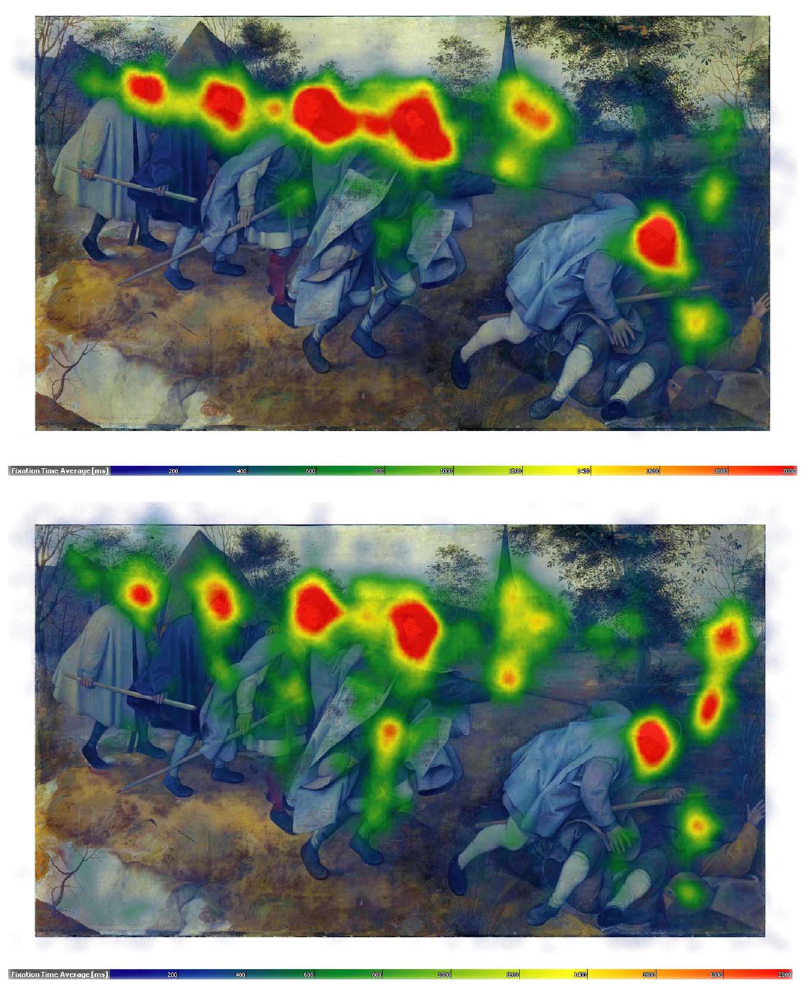
Fig. 3. Speaking effects on fixation dispersion and duration – Bruegel. Upper part: Heat map visualising the total time certain areas of the painting have been fixated by the experimental group during minute 11 to 15. Areas fixated for more than 2,000 ms/minute are displayed in red. Colour scaling is in 200 ms steps. Lower part: Heat map visualising the total time certain areas of the painting have been fixated by the control group during minute 11 to 15. Areas fixated for more than 2,000 ms/minute are displayed in red. Colour scaling is in 200 ms